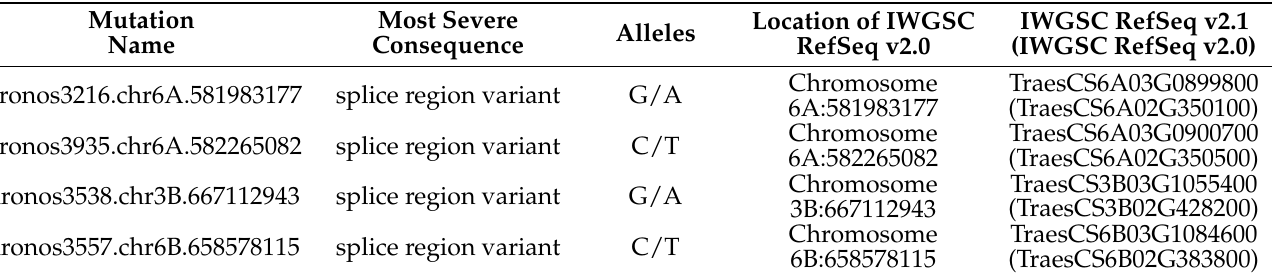
Table 2. EMS-induced mutation